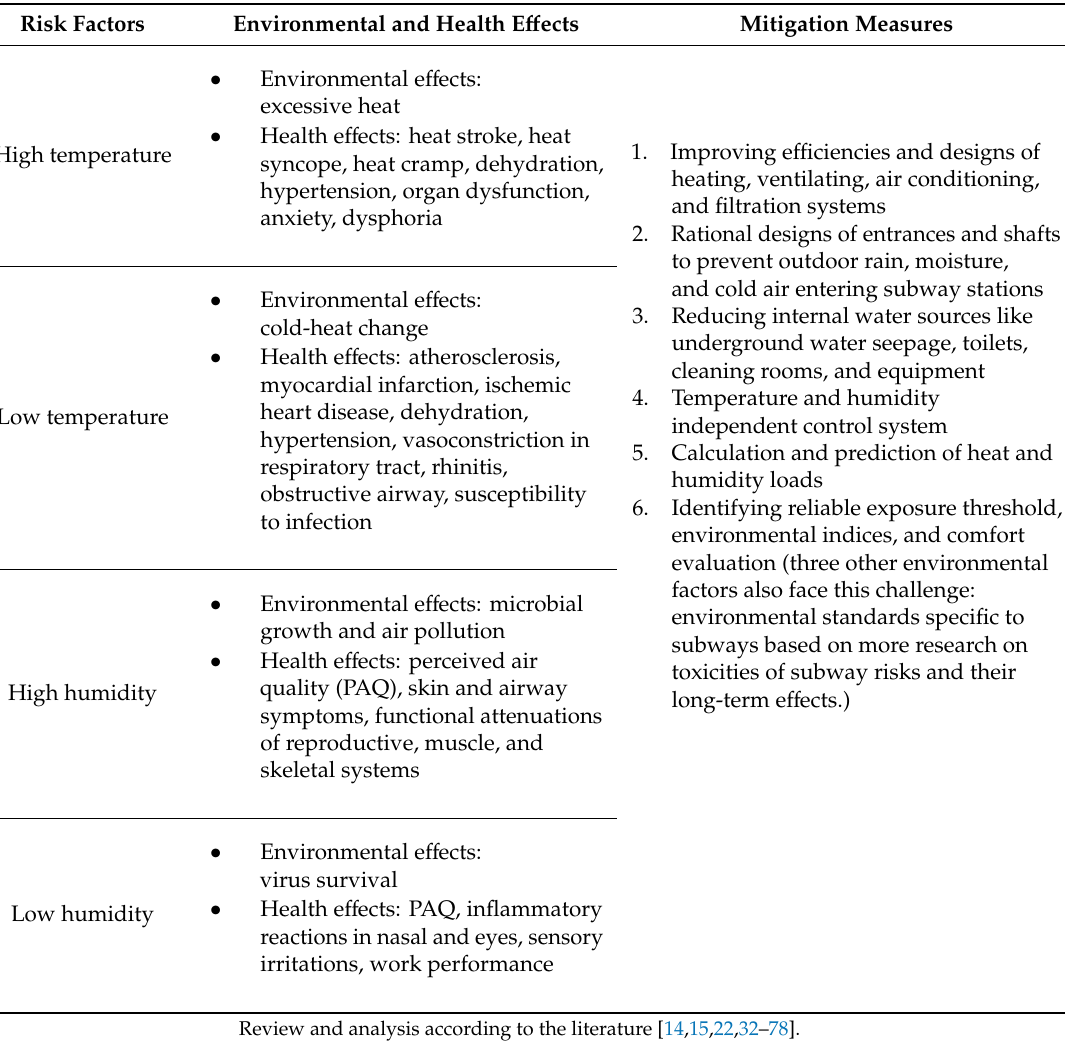
Table 1. Thermal